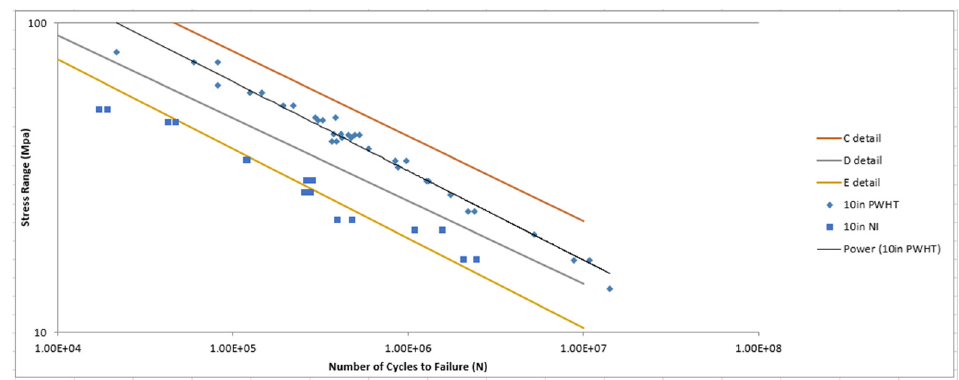
Figure 9. No insert detail vs. old 10 in data.